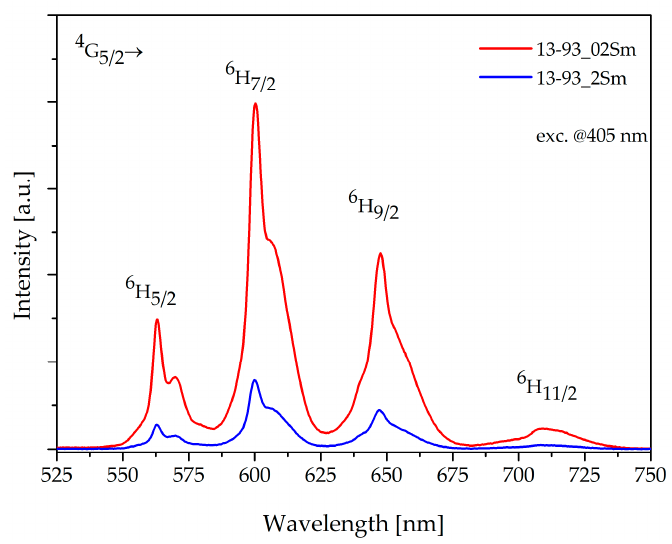
Figure 3. Luminescence spectra of 13-93 bioactive glass doped with 0.2 and 2 %mol Sm 3+ , λ exc = 405 nm.